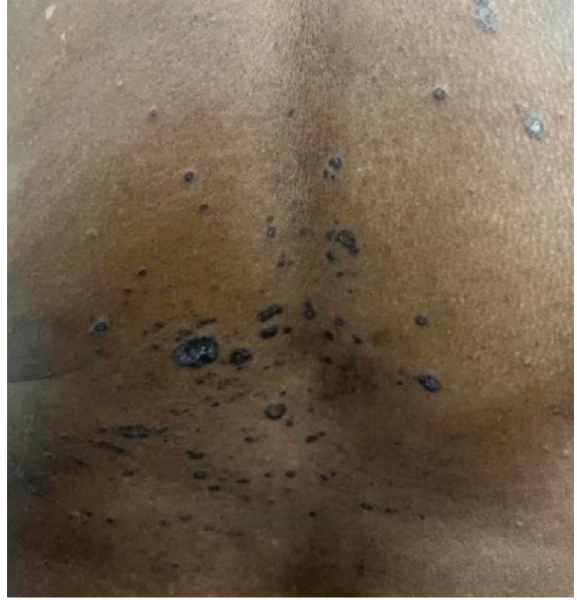
Figure 1: Multiple annular, hypertrophic, violaceous, well-de- marcated papules and plaques over the